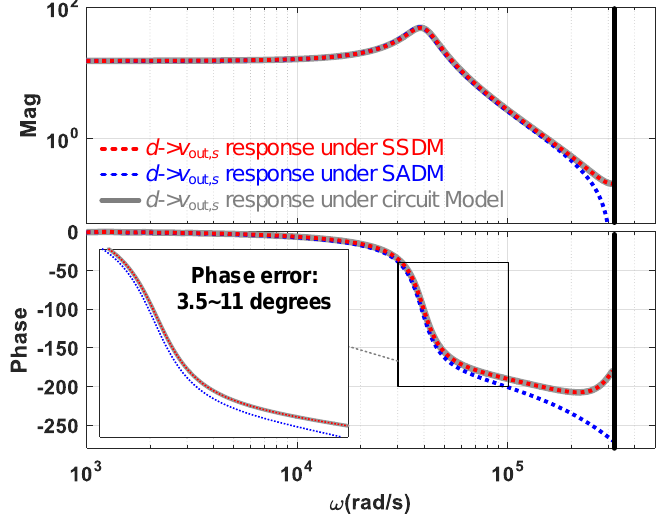
Figure 11. Frequency response from d to v out, s under the State Switched Discrete-time Model (SSDM), State Averaged Discrete-time Model (SADM), and circuit model.